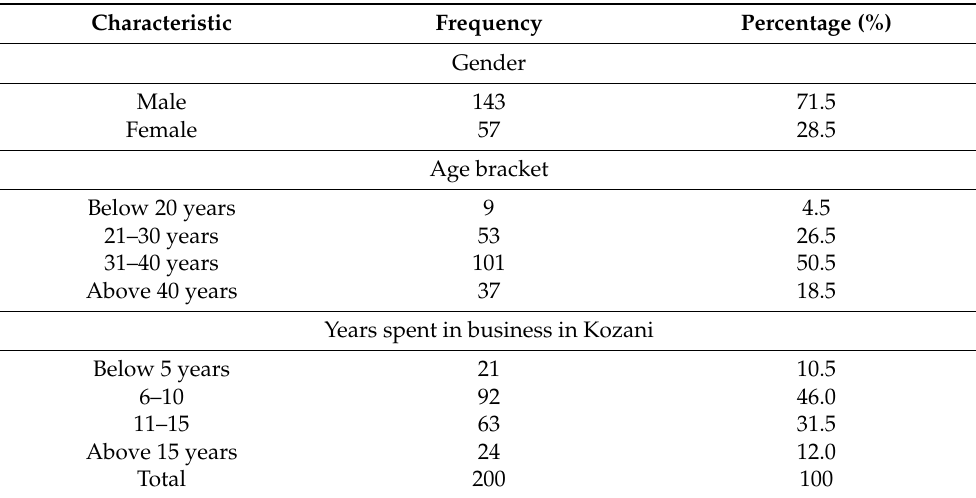
Table 1. Demographic characteristics of the respondents.